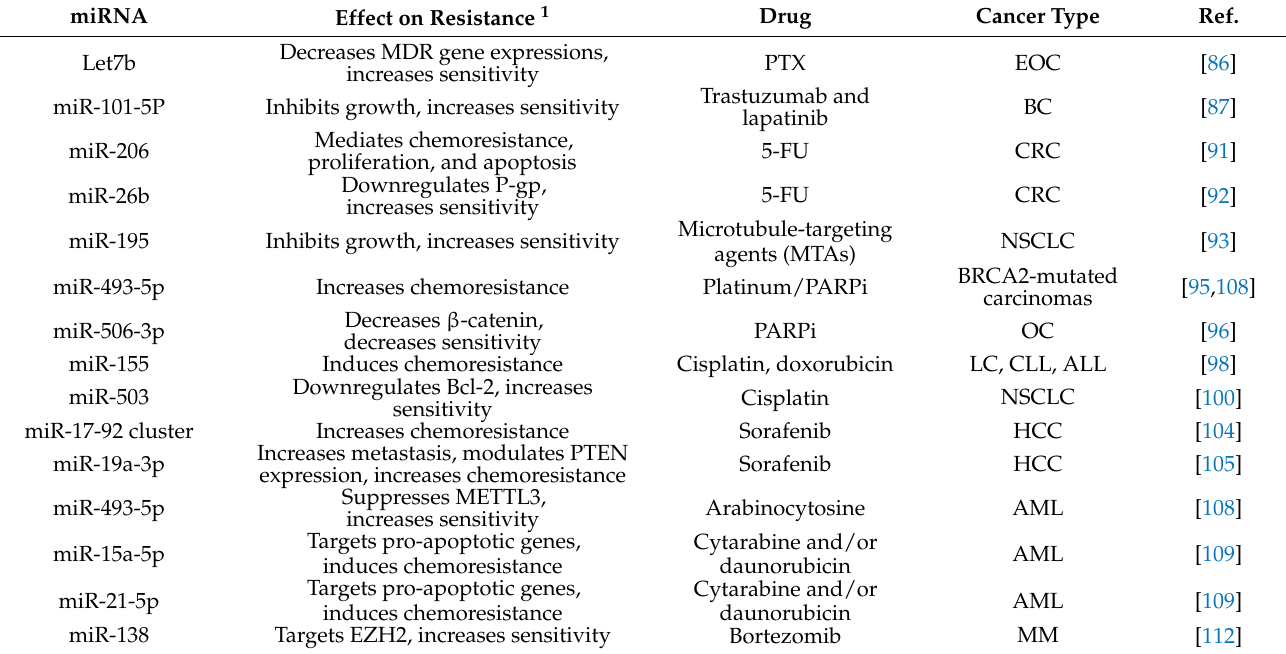
Table 2. miRNAs involved in the regulation of cancer therapy